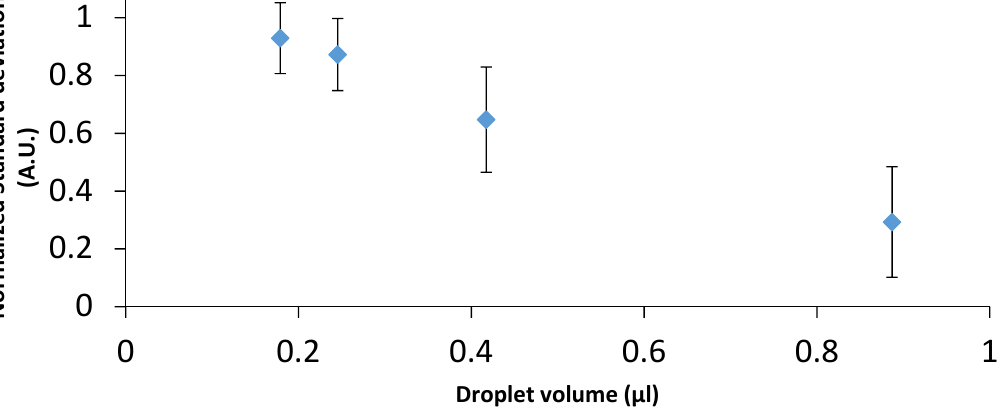
Figure 7. Normalized standard deviation of mixed aqueous solutions as a function of the droplet size provided by the two disc-based siphons. A value of unity corresponds to perfect mixing. The measured standard deviations were calibrated against the standard deviation of a sample processed by a conventional vortex mixer.